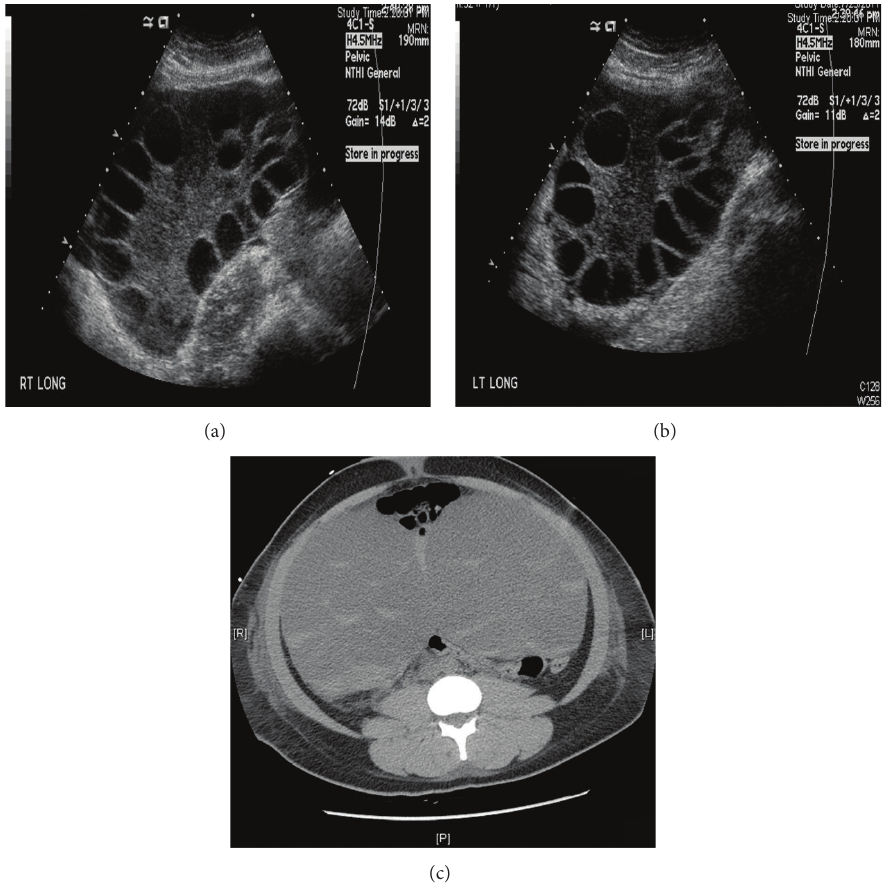
Figure 1: Ultrasound images showing enlarged right and left ovaries with multiple peripherally enlarged follicles. (a) Right ovary measuring 18 × 14 × 11cm 3 , (b) left ovary measuring 17 × 12 × 12cm 3 , and (c) computed tomography of the abdomen and pelvis showing bilateral enlarged multilocular and cystic